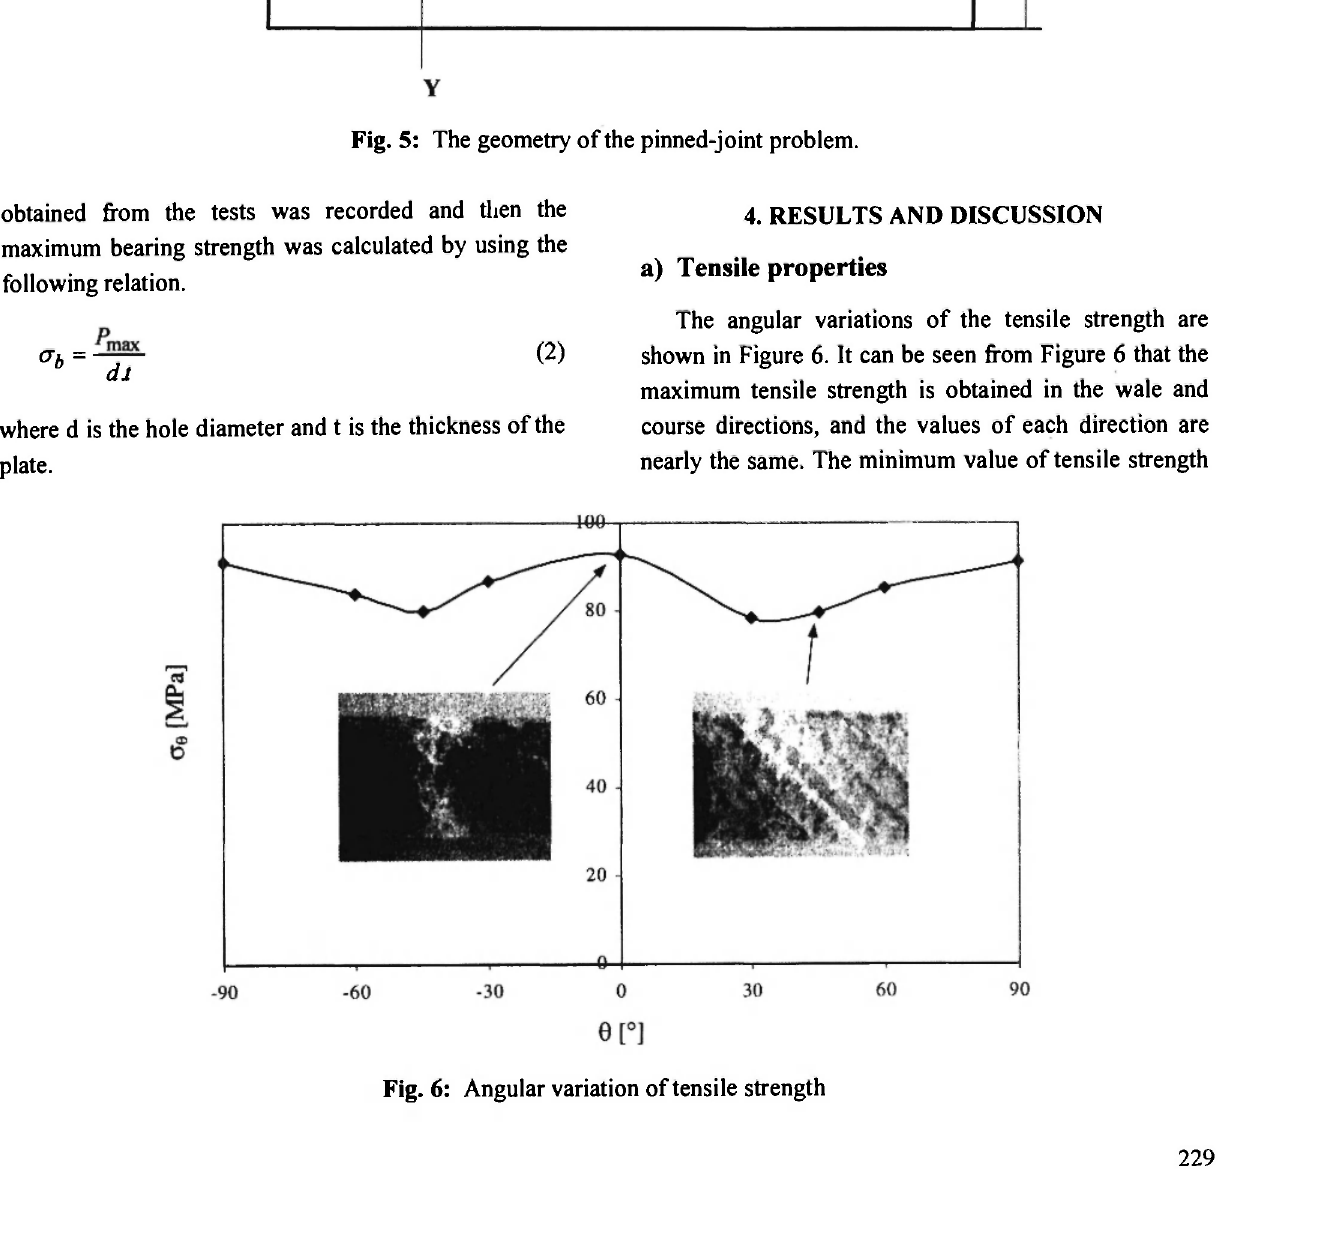
Fig. 5: The geometry of the pinned-joint problem.